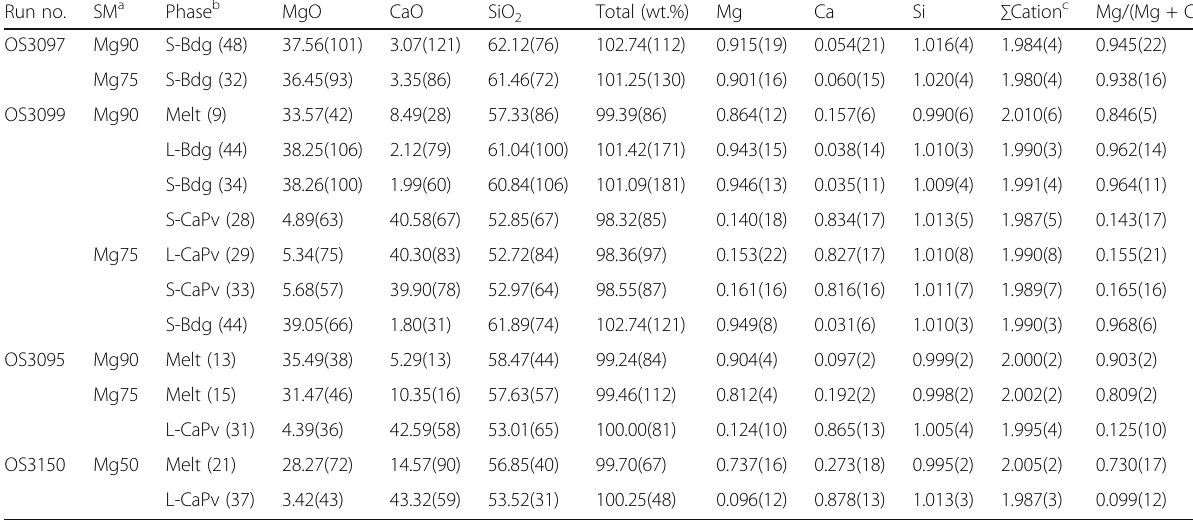
Table 5 Chemical compositions of phases in run products Run